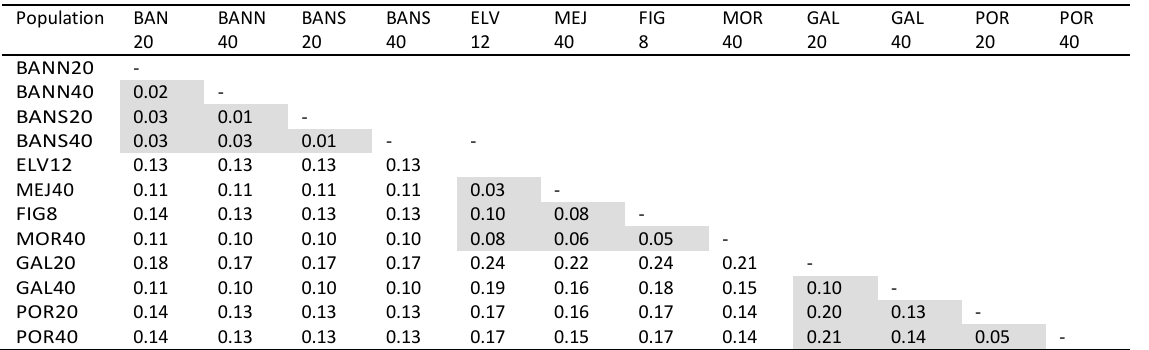
highlighted. FIG 8